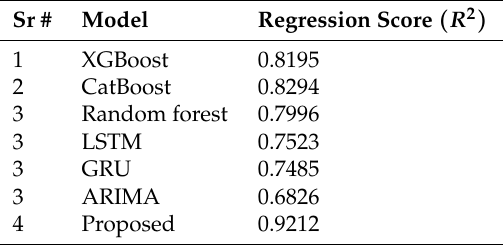
Table 4. Comparison of overall regression score with existing models.